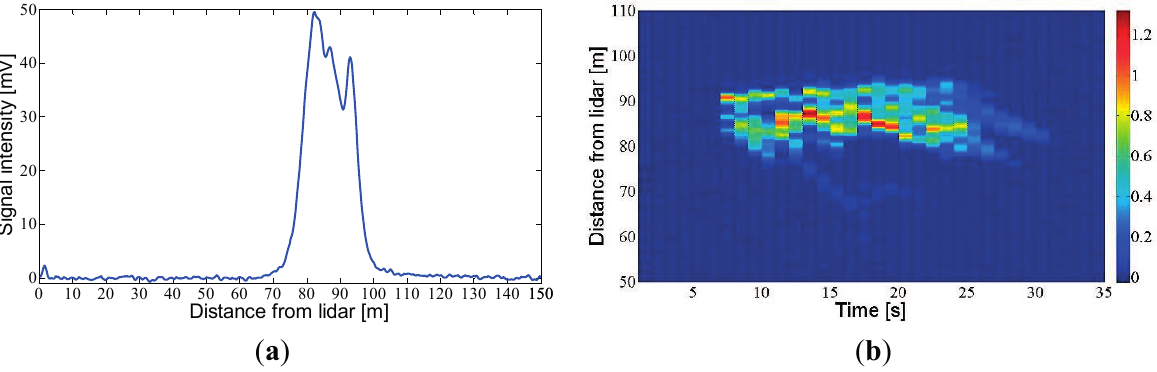
Figure 10. Detection of pesticide clouds generated by a cross-flow air-assisted